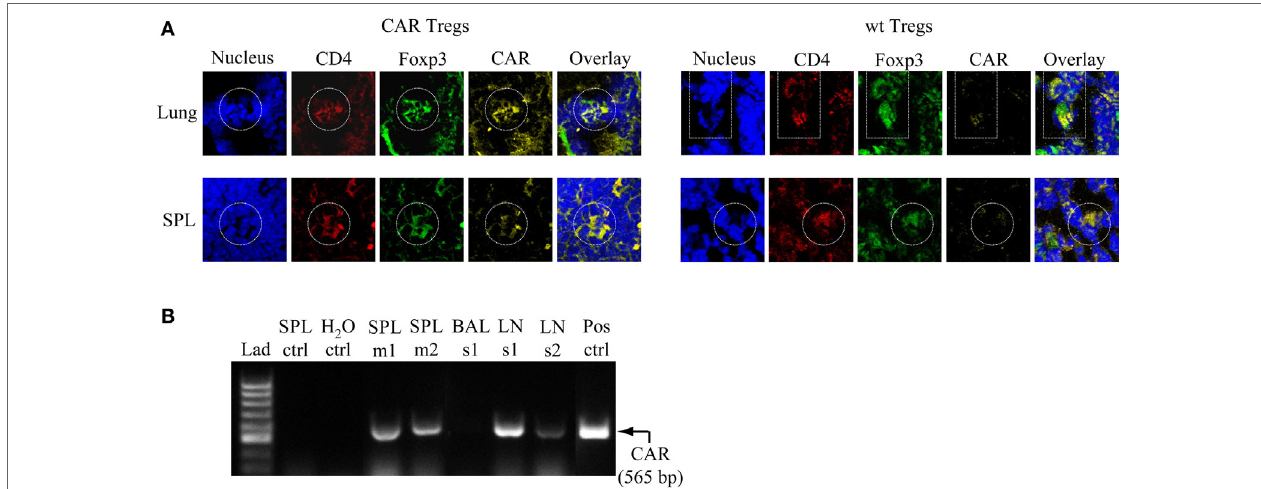
FigUre 6 | Chimeric antigen receptor (CAR) regulatory T cells (Tregs) accumulate in the lung, spleen (SPL), and tracheobronchial lymph nodes (LNs) after challenge with antigen. (a) Lung and SPL cells were isolated at day 13 from carcinoembryonic antigen transgenic mice treated with CAR Tregs or non-modified [wild-type (wt)] Tregs and fluorescently stained for nuclei (DAPI), and CD4, FoxP3, and CAR expression. One representative mouse out of three per group is shown. (B) Detection of CAR Tregs in the SPL and tracheobronchial LNs by RT-PCR at the end of experimental protocol (day 13). The specific RT-PCR CAR fragment is 565 bp in size. As expected, tissues from mice which received non-modified Tregs (SPL ctrl) did not show a CAR-derived signal. Bronchoalveolar lavage fluid (BALF) did not contain detectable CAR Treg cells. Lad, ladder of DNA fragments of different sizes; H 2 O ctrl, RT-PCR in the absence of RNA; Pos ctrl, RT-PCR with RNA from purified CAR T cells; m, mouse; s, sample consisting of cells that are pooled from five to six